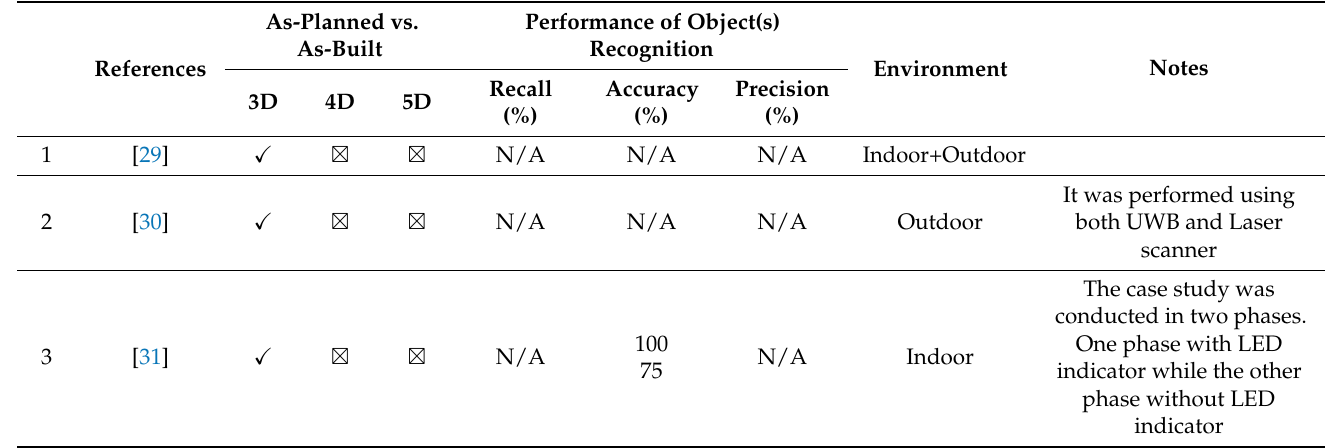
Table 3. Studies of UWB integrated with BIM in CPM: 2007–2021.